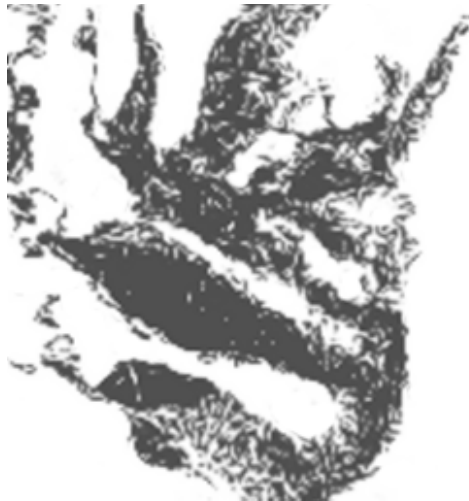
Figure 8. A mineral map derived from AVIRIS data.